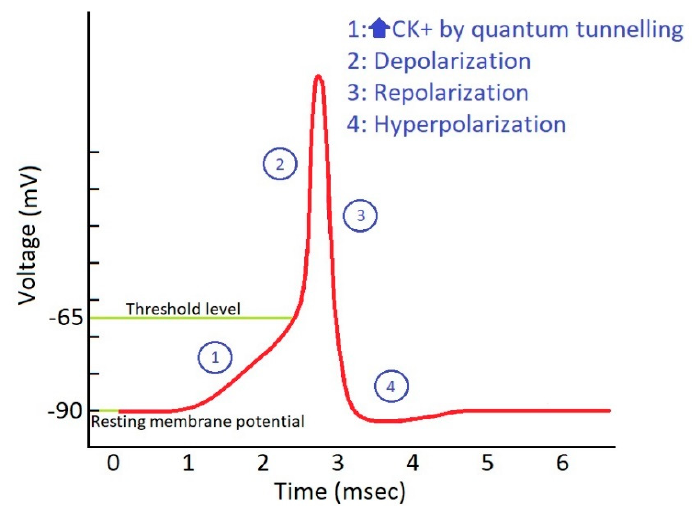
Figure 1. Action potential in phantom axons: role of potassium ion conductance and threshold level.